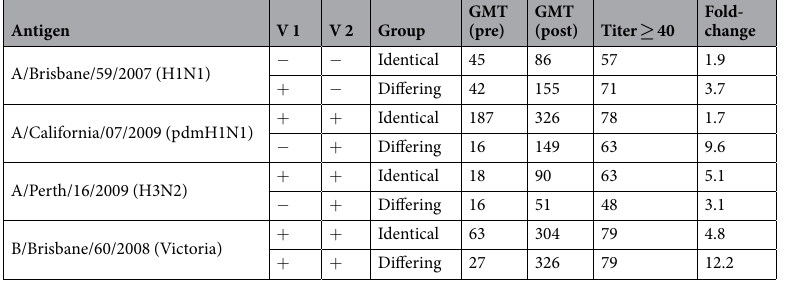
Table 2. HI Data for Pandemic Shift Cohort vaccinated in 2009–2011. The names of the antigens used in the HI assay are listed in the first column. In the second and third columns + and − are used to indicate if the antigen was used in the first (V1) or second (V2) vaccination. The geometric mean titers prior to vaccination (pre) and after both vaccinations (post) are shown for each antigen for each group (Identical or Differing). The number of titers ≥ 40 is shown as a percentage. The fold-change is the average increase between the pre- and post- vaccination titers.